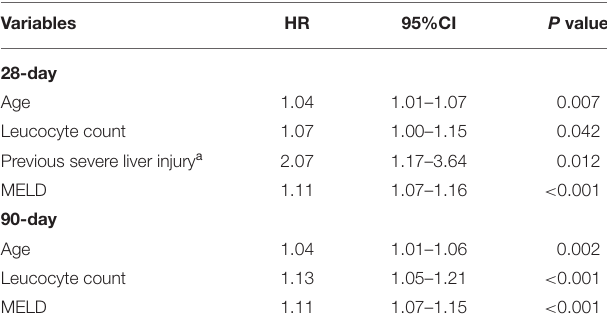
TABLE 4 | Risk factors associated with mortality in decompensated cirrhosis patients.